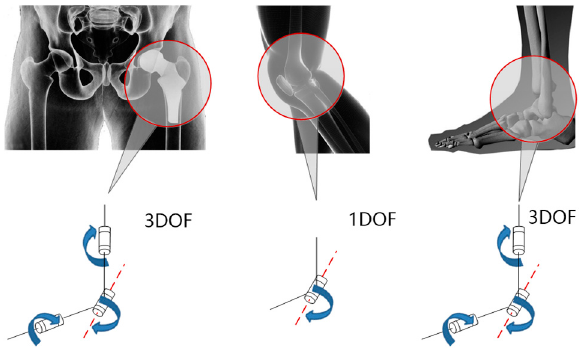
Figure 6. Joint simplification.